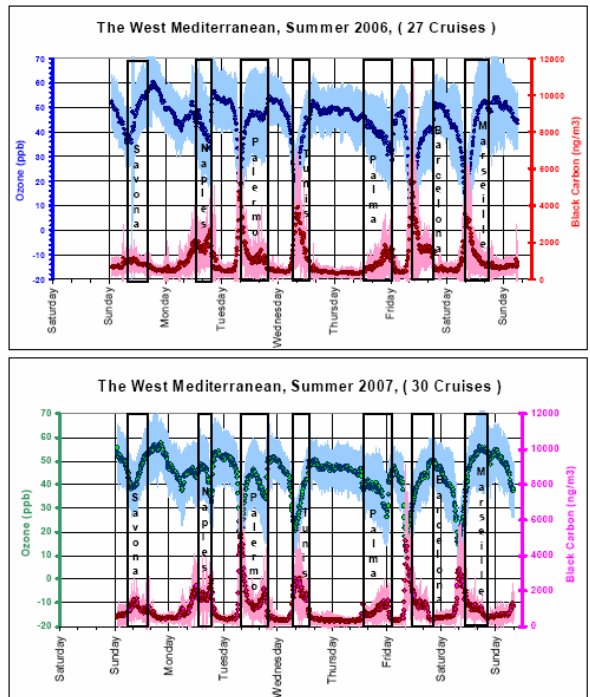
Fig. 4. Ozone and black carbon concentrations in the West Mediter- ranean as measured along the cruise track. The figure shows aver- age values with standard deviation for the periods April–October 2006 and 2007. The black columns show the periods where Costa Fortuna is at berth in ports. 17